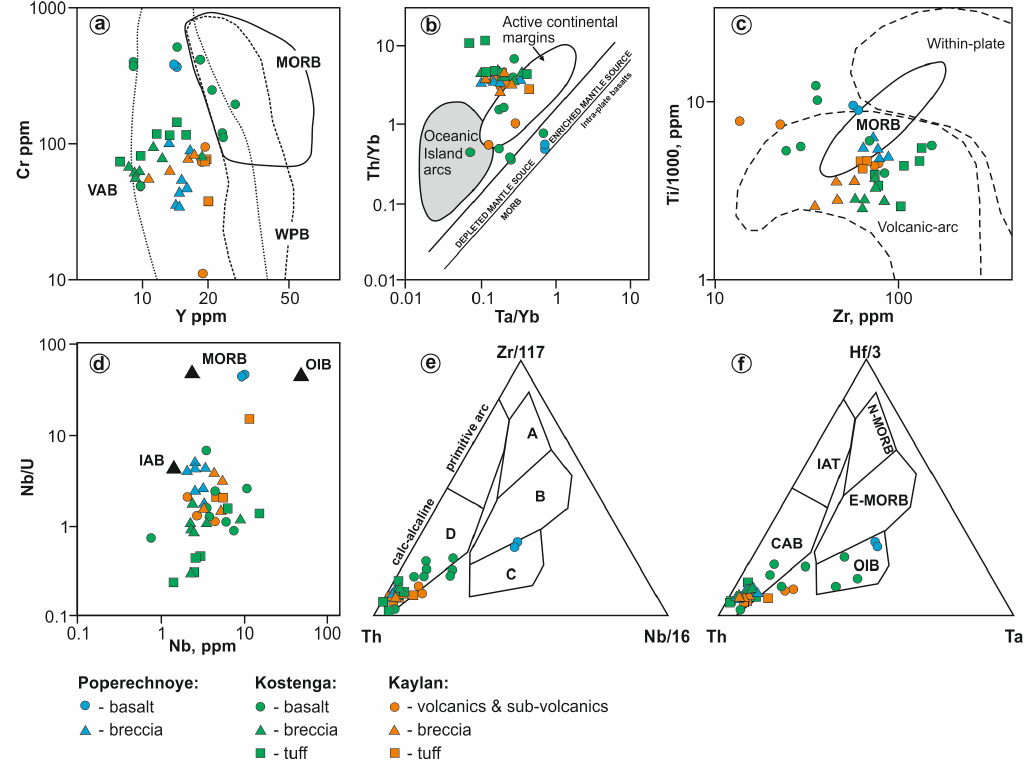
Figure 7. Tectonomagmatic discrimination diagrams for volcanic rocks associated with iron-oxide mineralization in the Lesser Khingan Range: ( a ) Cr-Y [70]; ( b ) Th/Yb-Ta/Yb [71]; ( c ) Ti-Zr [70]; ( d ) Nb/U-Nb [72]; ( e ) Th-Zr-Nb [73] (A—N-